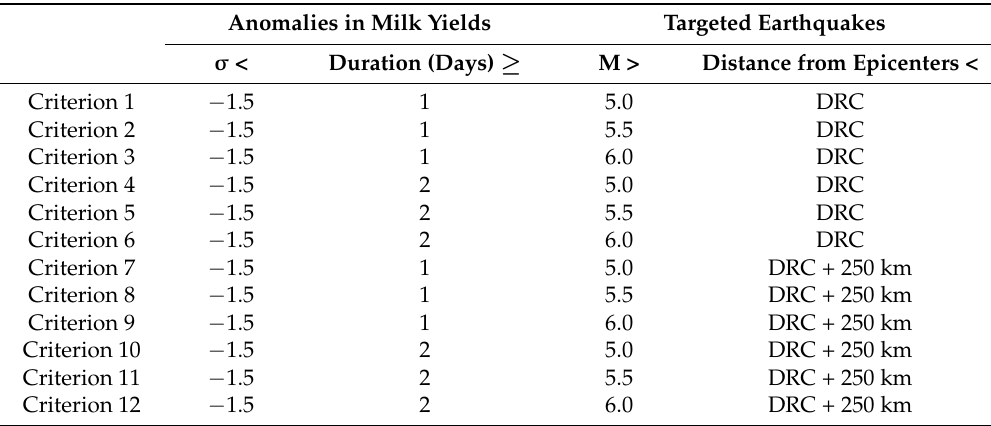
Table 4. The definitions in anomalies of milk yields and targeted earthquakes based on each criterion; M = magnitude; DRC = Dobrovolsky radius condition; σ = standard